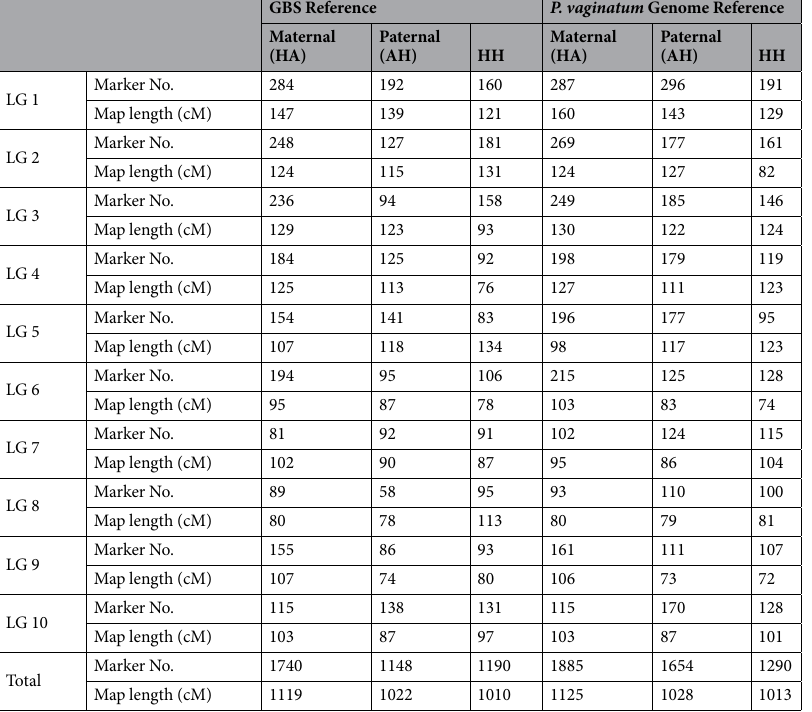
Table 1. Marker number and length for the generated genetic